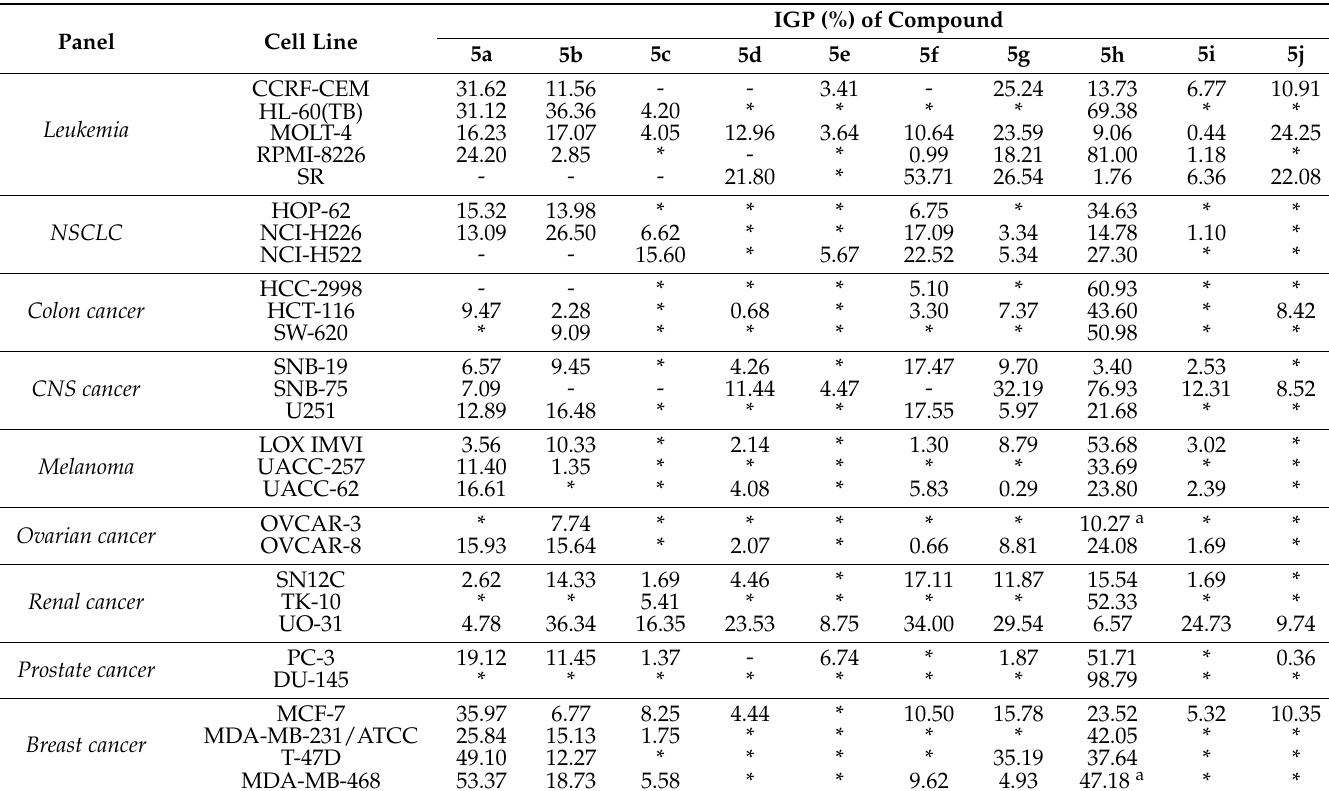
Table 1. The inhibition growth percent of selected NCI-60 cancer cells (IGP) at a single concentration of 10 ´ 5 M of novel 1,4,2-benzodithiazine derivatives 5a – j .